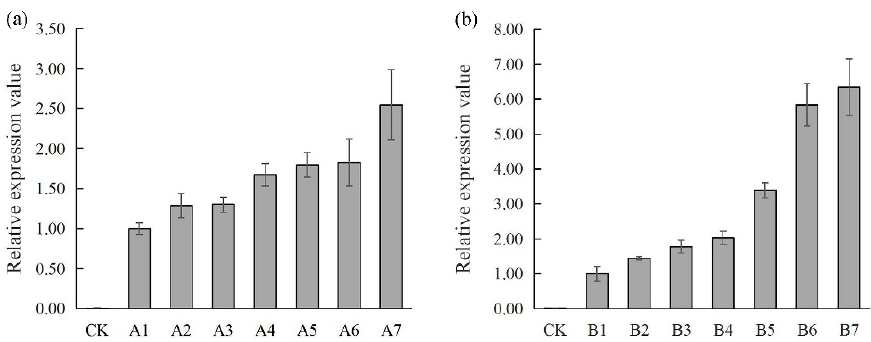
Figure 6. The 35S::MapaAGL6-1 and 35S:: MapaAGL6-2 independent homozygous transformants under Arabidopsis ap1-10 mutant background identified by qPCR, respectively. ( a ) The relative expression of MapaAGL6-1 was detected in the homozygous ap1-10 mutant Arabidopsis ; ( b ): Expression of MapaAGL6-2 was confirmed in the homozygous ap1-10 mutant Arabidopsis . (CK) Homozygous ap1-10 mutant Arabidopsis ; (A1) 35S::MapaAGL6-1 transgenic line without phenotypic change; (A2, A3, and A4) 35S::MapaAGL6-1 transgenic lines displayed medium rescue phenotypes; (A5, A6, and A7) 35S::MapaAGL6-1 transgenic lines showed strong complementation phenotypes; (B1, B2, B3, and B4) 35S::MapaAGL6-2 transgenic lines without phenotypic change; (B5, B6, and B7) 35S::MapaAGL6-2 transgenic lines displayed phenotypic changes in floral structure.